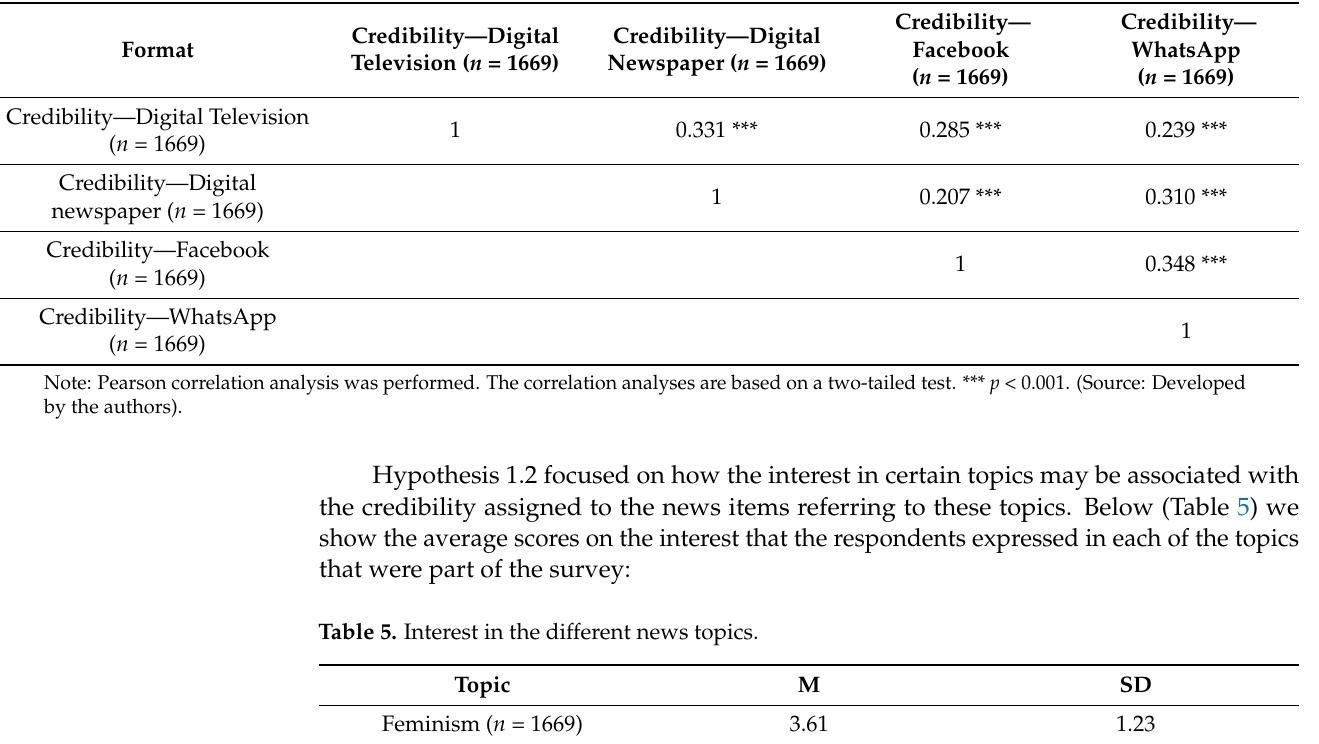
Table 4. Correlation coefficients of credibility in each format.